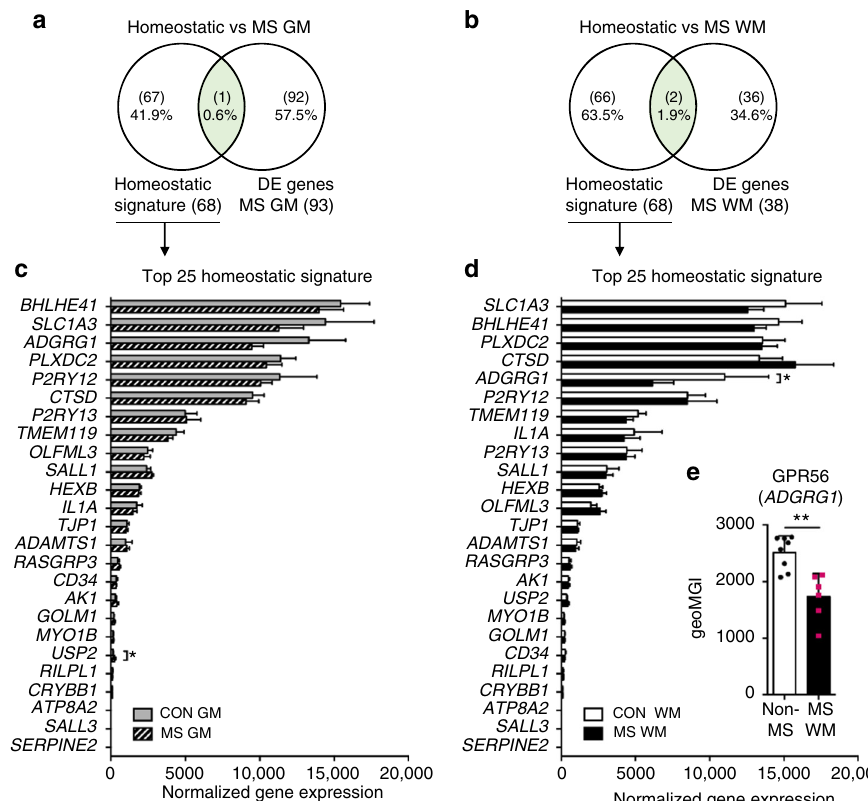
Fig. 4 Conservation of homeostatic gene expression in microglia from normal-appearing multiple sclerosis (MS) tissue. a , b Venn diagrams show hardly any overlap between homeostatic genes identi fi ed in mouse microglia 15 and differentially expressed genes for grey matter (GM; n = 5) and white matter (WM; n = 10) MS microglia. c , d Expression of 25 homeostatic signature genes is amply changed in human microglia from both MS GM and WM, except for USP2 upregulation in GM and ADGRG1 downregulation in WM MS microglia. Two-way ANOVA: * adjusted p <0.05. e Flow cytometric analysis con fi rms downregulation of GPR56 protein expression in MS WM microglia ( n = 6) compared to non-MS WM microglia ( n = 8). Mann – Whitney U test: ** p < 0.01. Bars show mean with standard